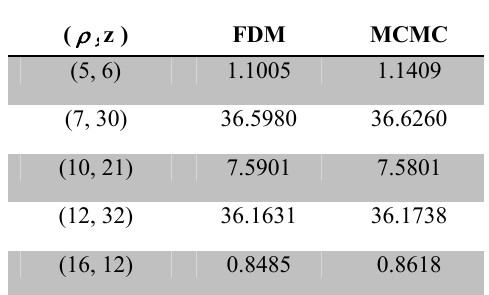
for Axisymmetric